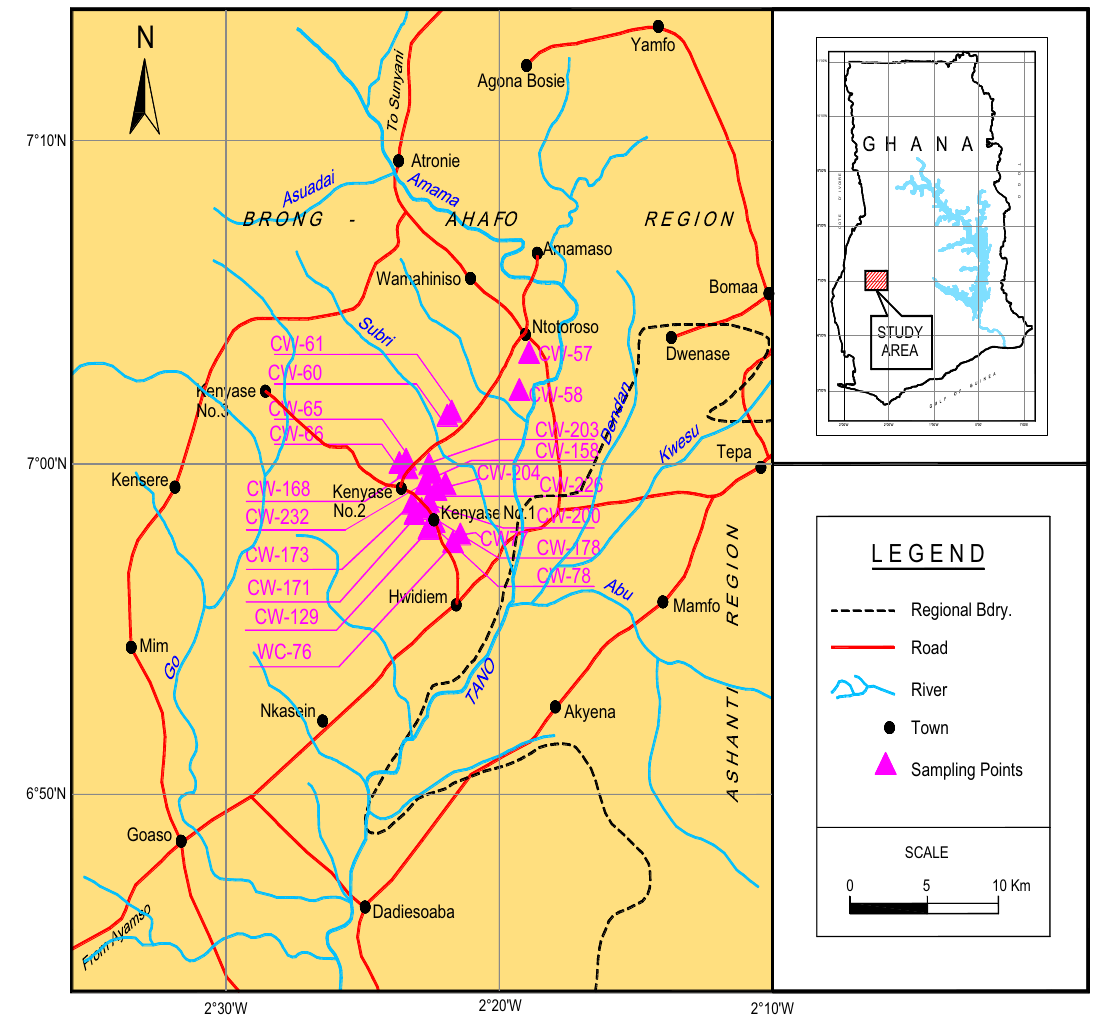
Fig. 3 Map of the study area (insert map of Ghana) showing sampling